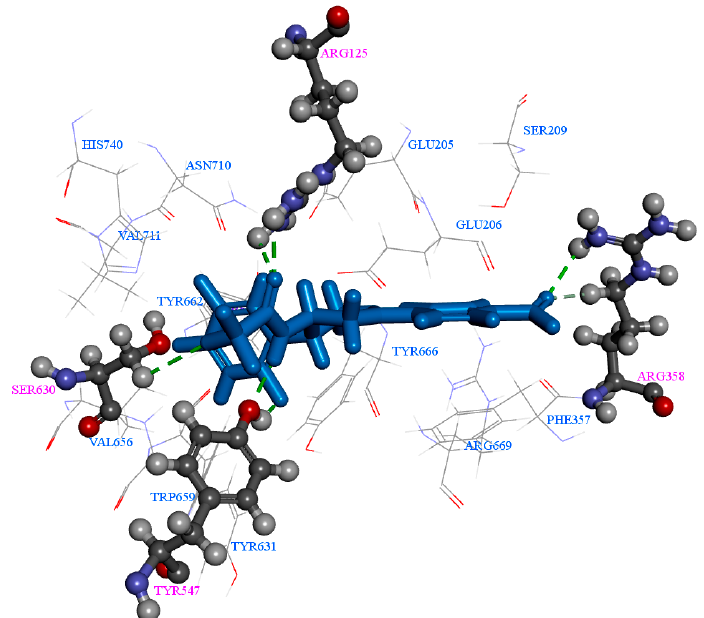
Figure 4. Molecular docking (CDOCKER) interactions of 2P8S_Comp71 with seven H-bonds. H-bond interactions are denoted as dotted lines. Active site amino acid residues Arg125, Arg358, Tyr547, and Ser630 are participating in H-bonding. There is one H-bond from Ser630 and two H-bonds from Arg125, Arg358, and Tyr547, respectively. Table 1. Calculated energies of CDOCKER and the number of H-bonds involved during molecular docking simulation.